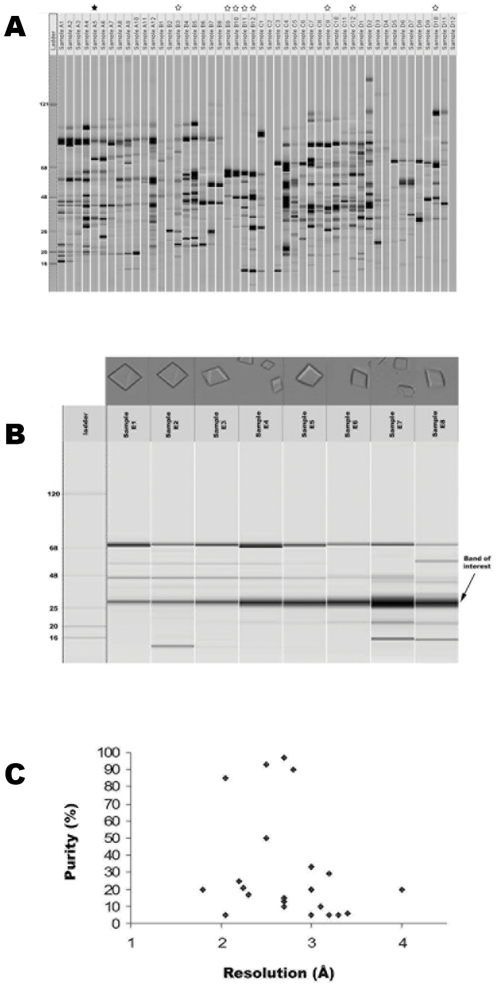
Crystallization of native source E. coli proteins.(A) Capillary electrophoresis of purified protein fractions. White stars indicate samples successfully crystallized and black stars represent solved structures. (B) Crystals of 5-keto-4-deoxyuronate isomerase crystallized from fractions of varying purity. Crystal quality was not always correlated with sample purity. (C) Resolution of the data collected versus percent purity of the starting sample based on quantification of protein concentrations by capillary gel electrophoresis with the Caliper system. Sample purity did not correlate with higher resolution data.